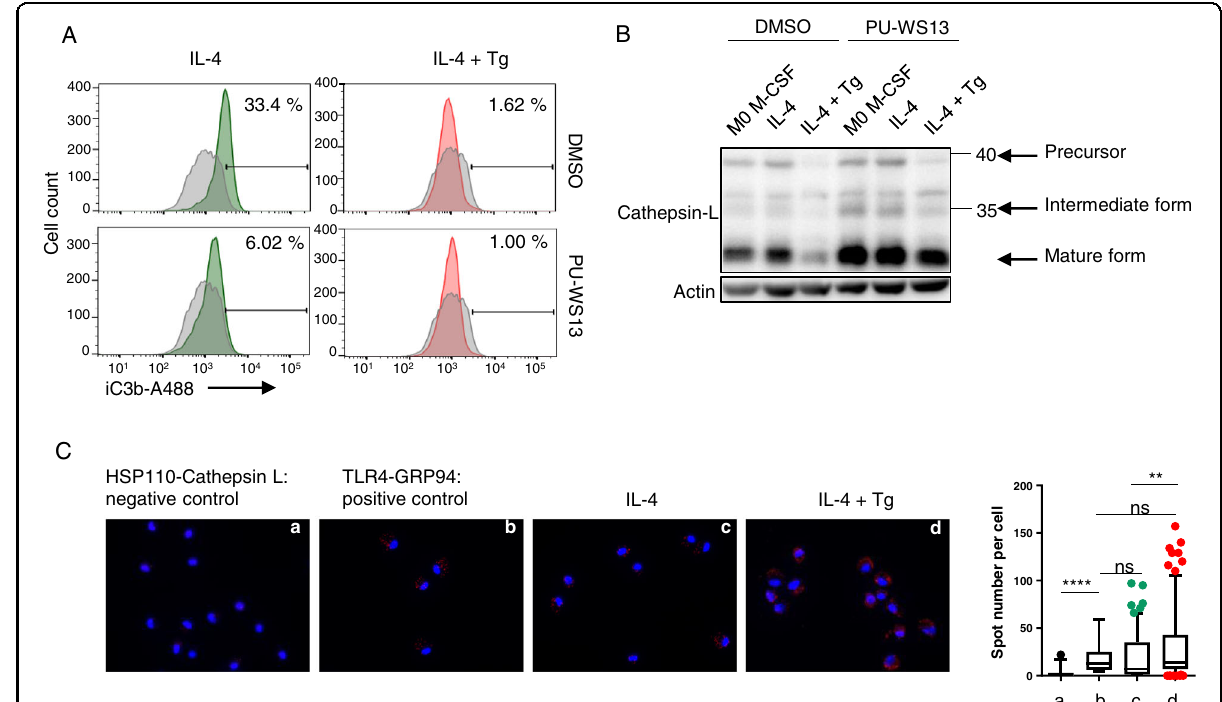
Fig. 7 GRP94 affects membrane-bound iC3b and intracellular cathepsin L. A FACS analysis of iC3b membrane-bound on 48 h activated M2 macrophages treated or not with Tg, in the presence or absence of PU-WS13 ( n = 4). B Western-blot analysis of cathepsin-L in lysates from M2 macrophages treated or not with Tg and pretreated or not with PU-WS13 ( n = 4). C Staining and quanti fi cation of proximity ligation assay (Duolink ™ PLA) between cathepsin L and GRP94 in M2 macrophages treated or not with Tg ( n = 4) (* p < 0.05; ** p < 0.01; *** p < 0.005; **** p <